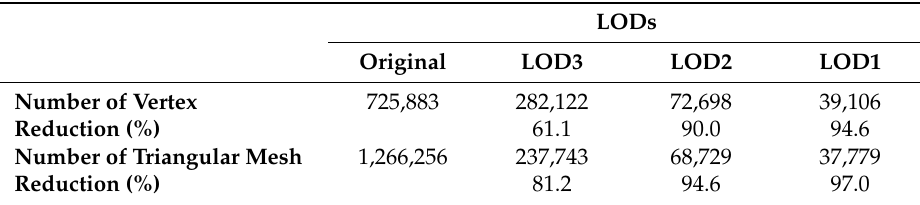
Table 2. Data volume reduction for multi-scale simplification of the